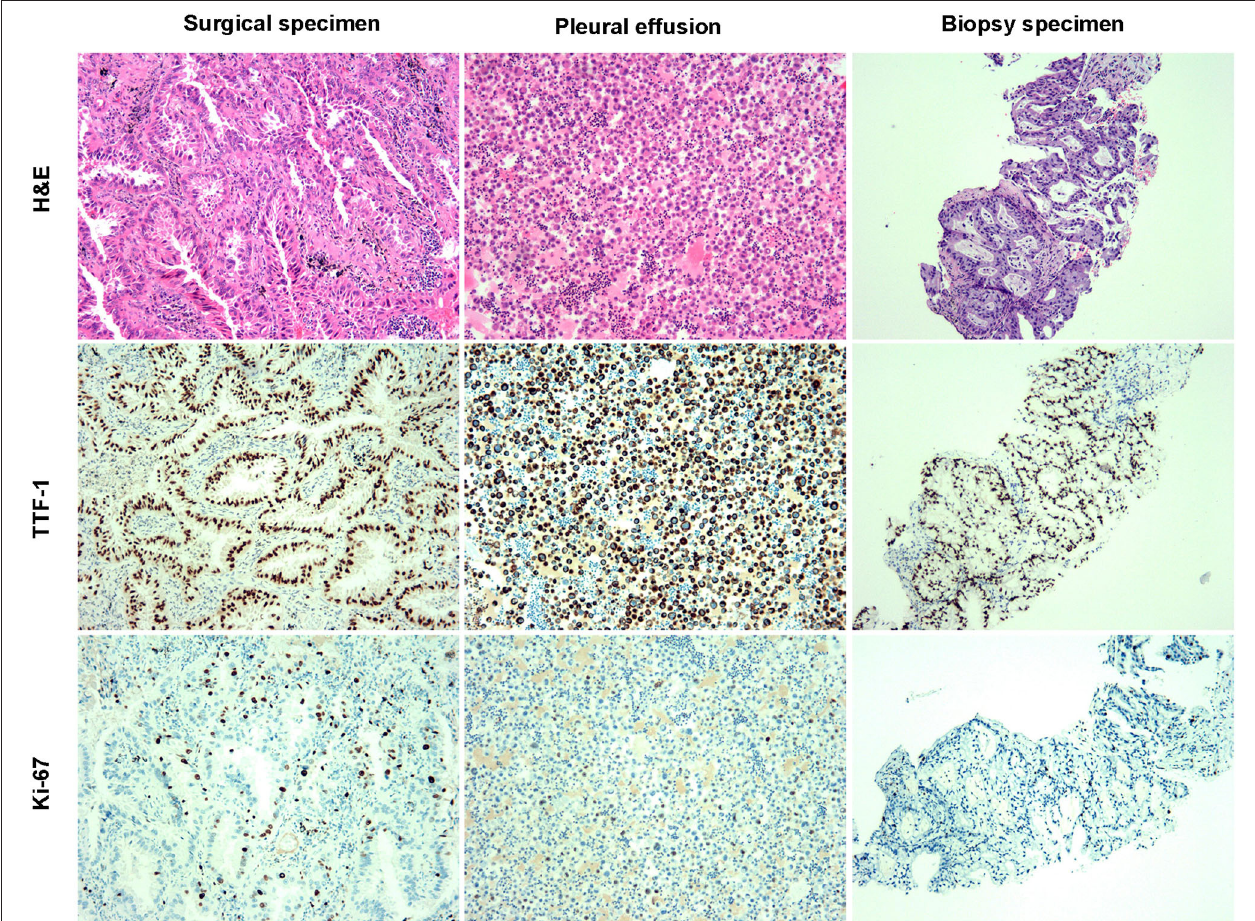
FIGURE 2 | The pathological diagnosis of specimens was lung adenocarcinoma. H and E staining and immunohistochemistry staining of surgical, pleural effusion, and biopsy specimens.